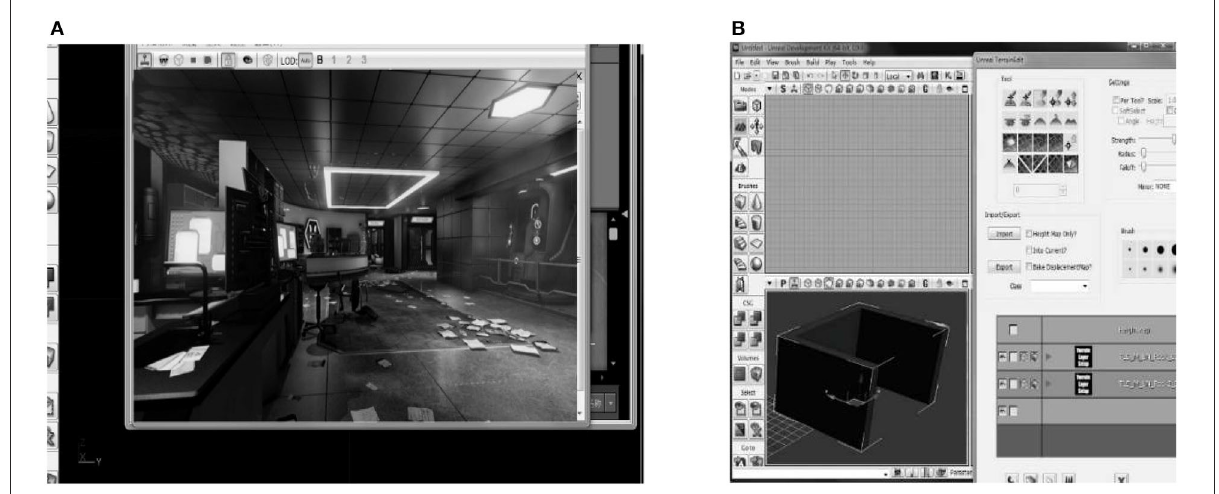
FIGURE7 Schematic diagram of the application of the component modeling system [ (A) is the assembly modeling software; (B) is the import process of the software model]. Reproduced with permission from CITN Lab Work Department, available at www.citn.ac.cn.